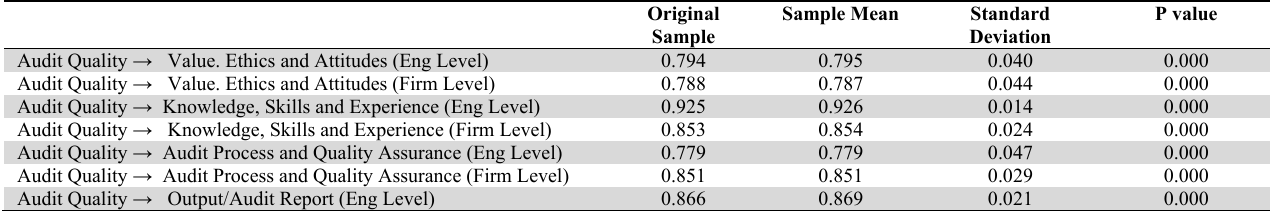
The Result of Hypotheses